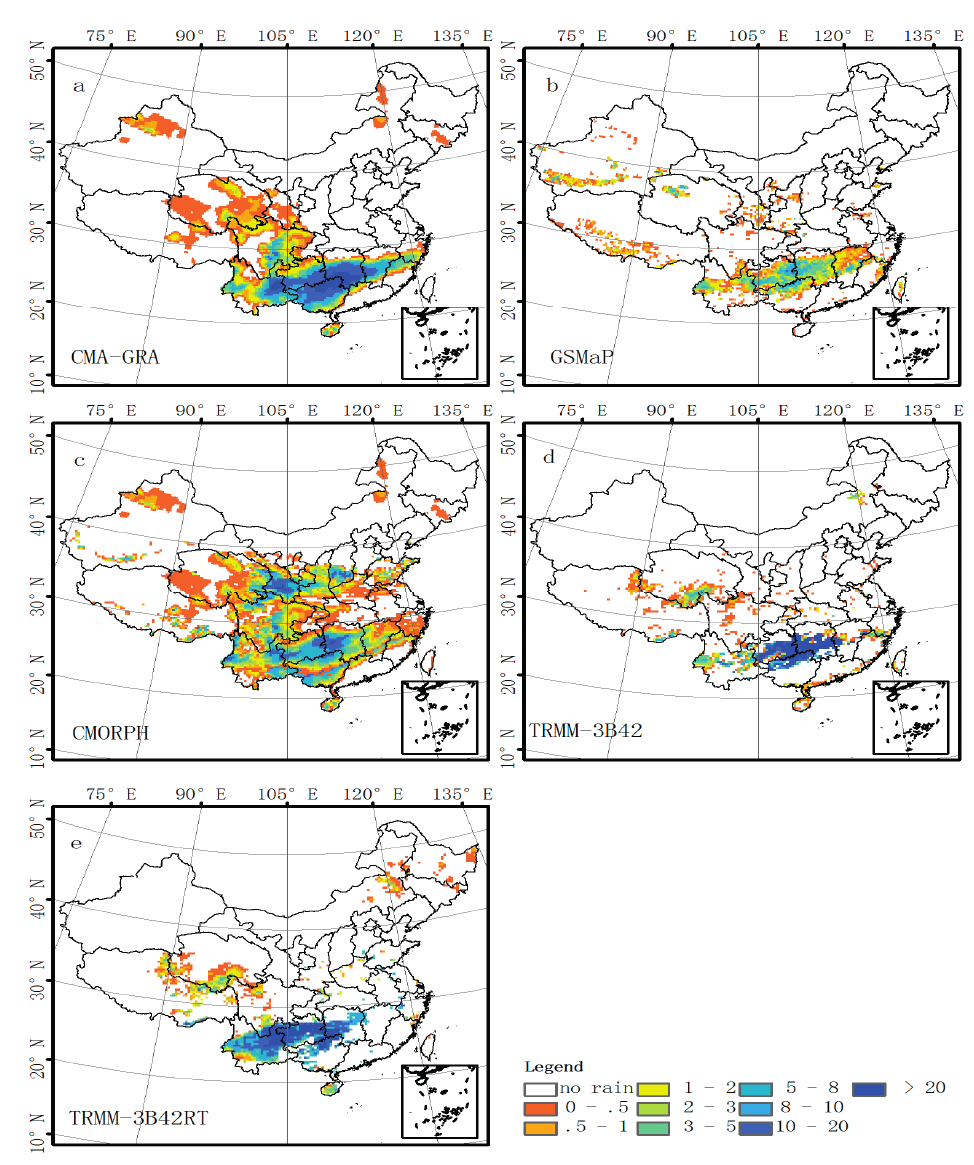
Figure 4. Snapshots of daily precipitation patterns on an arbitrary winter day (12 January 2005) for ( a ) CMA, ( b ) GSMaP, ( c ) CMORPH, ( d ) TRMM 3B42 and ( e ) TRMM 3B42RT. Units are